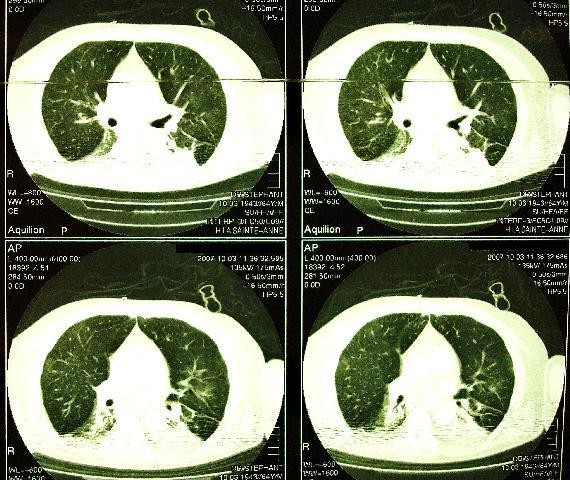
CT Scan on day 5.